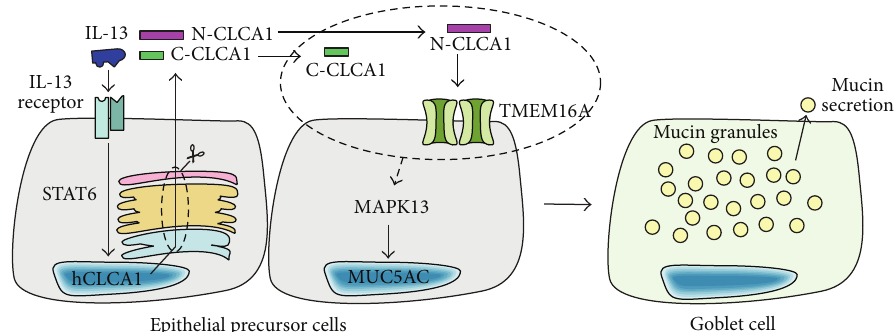
Figure 2: Schematic of CLCA1-driven MCM in human airways based on the current literature. IL-13 induces CLCA1 gene expression through activated STAT6. CLCA1 protein is expressed, is secreted, and undergoes proteolytic self-cleavage to yield two fragments (N-CLCA1: N-terminal fragment; C-CLCA1: C-terminal fragment). N-CLCA1 engages and activates the CaCC TMEM16A. Downstream, a signaling pathway is activated through MAPK13 which leads to induction of the inflammatory mucin MUC5AC , followed by goblet cell differentiation and subsequent MCM. It is currently unknown whether or how the steps highlighted in the dashed ellipse (CLCA1 cleavage and activation of TMEM16A) contribute to the activation of